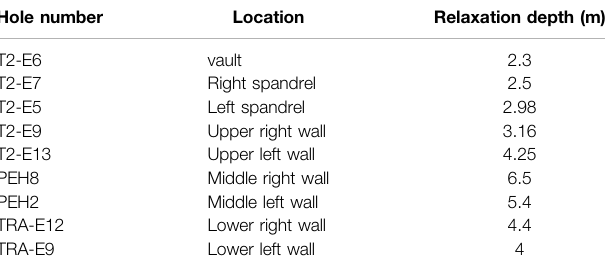
TABLE 7 | Acoustic detection results of the relaxation depth of the diversion